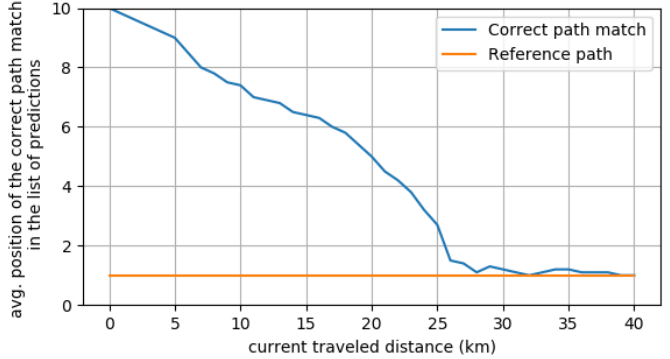
Figure 13. The average correct route match relative to the traveled distance. At halfway through the 40 km trip, the predicted route is within the top 5 matches, while in the last 10 km the predicted route is the top match.